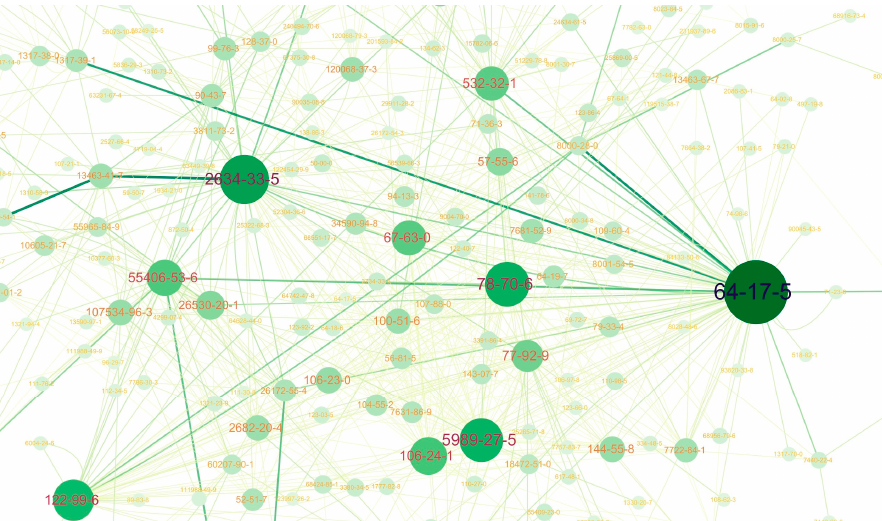
Figure 2. A part of the network visualization of chemical combinations in biocidal and household chemical products. Lines connect ingredients contained in the same product, and color-focused with larger size vertices means more abundantly used chemicals. The numbers in circles represent the CAS registry number of chemicals. Five compounds that have the high node’s degree in this part are shown as follows: 64-17-5 (ethanol), 2634-33-5 (BIT), 78-70-6 (linalool), 5989-27-5 (D-Limonene), and 122-99-6 (2-phenoxyethanol).